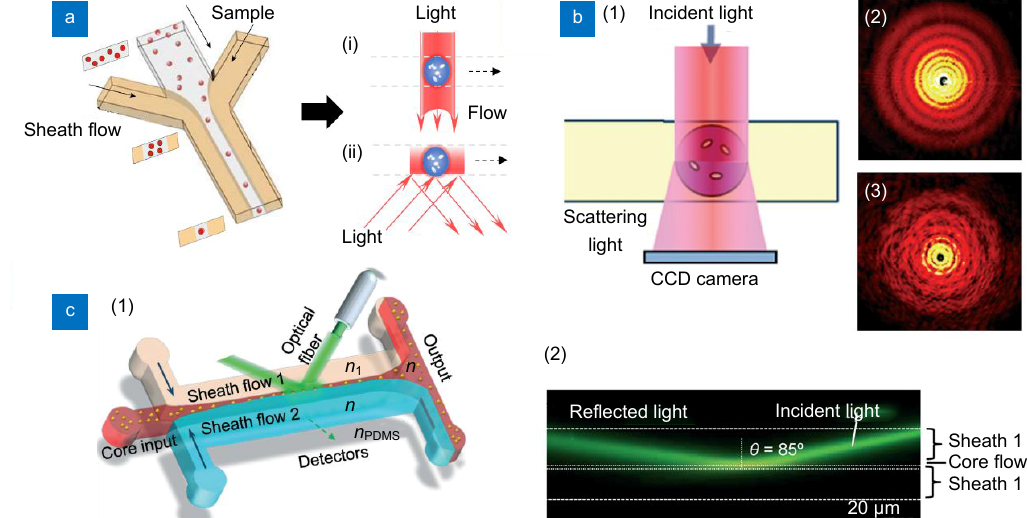
Fig. 5 | ( a ) The schematic of the on-chip flow cytometry, which is detected in two ways. One is detected by the traditional far-filed scattering light, and the other is detected by the near-field evanescent wave. ( b ) The Schematic diagram (1) and experimental images (2, 3) of a label-free bacte- riophage detection by using droplet optofluidic imaging and far-field scattering light. ( c ) The design (1) and experimental image (2) of the single nanoparticle detection by total internal reflection. Figure reproduced from: ( a ) ref. 51 , Springer Nature; ( b ) ref. 47 , ( c ) ref. 49 , The Royal Society of